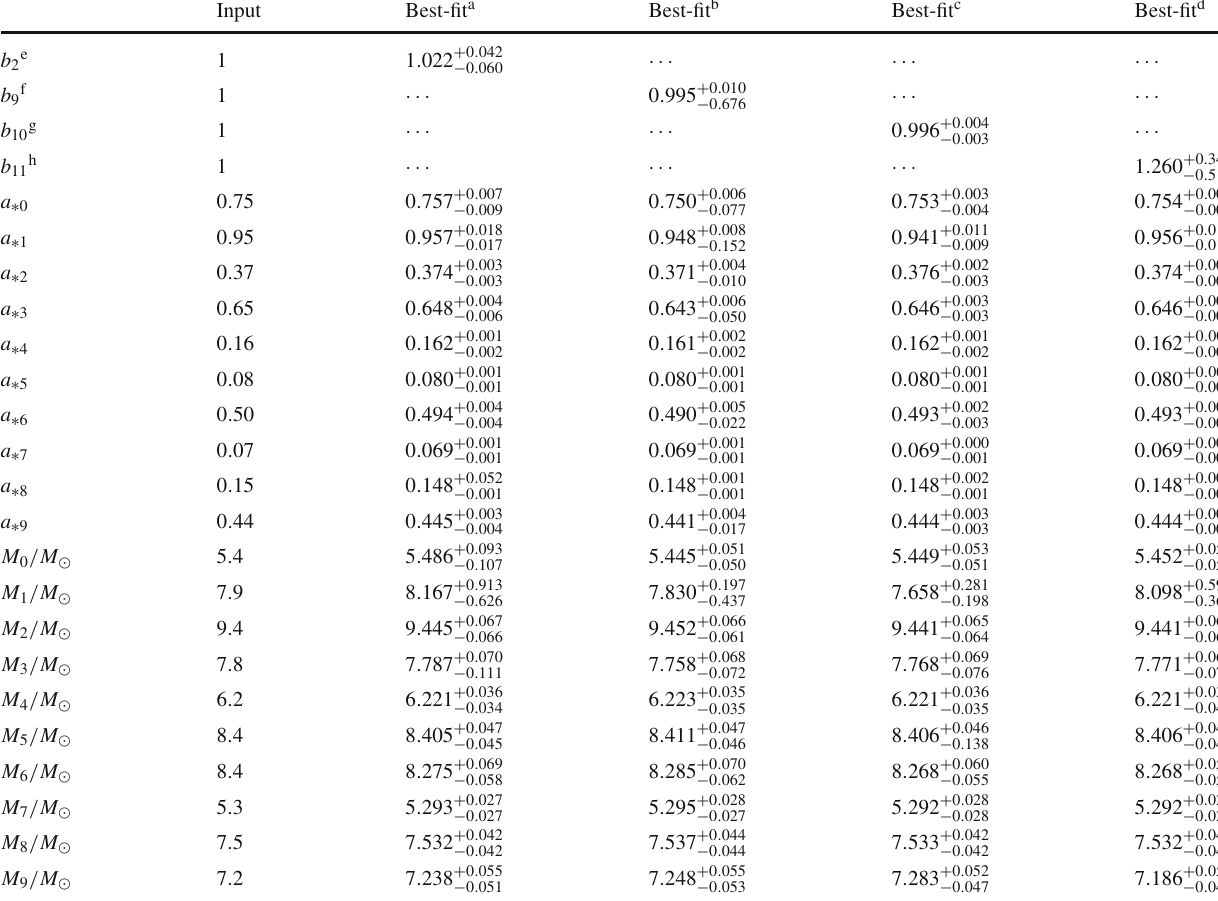
Table 1 Inferred values of the GB parameter from the mock observations generating by assuming the Kerr metric Input Best-fit a Best-fit b Best-fit c Best-fit